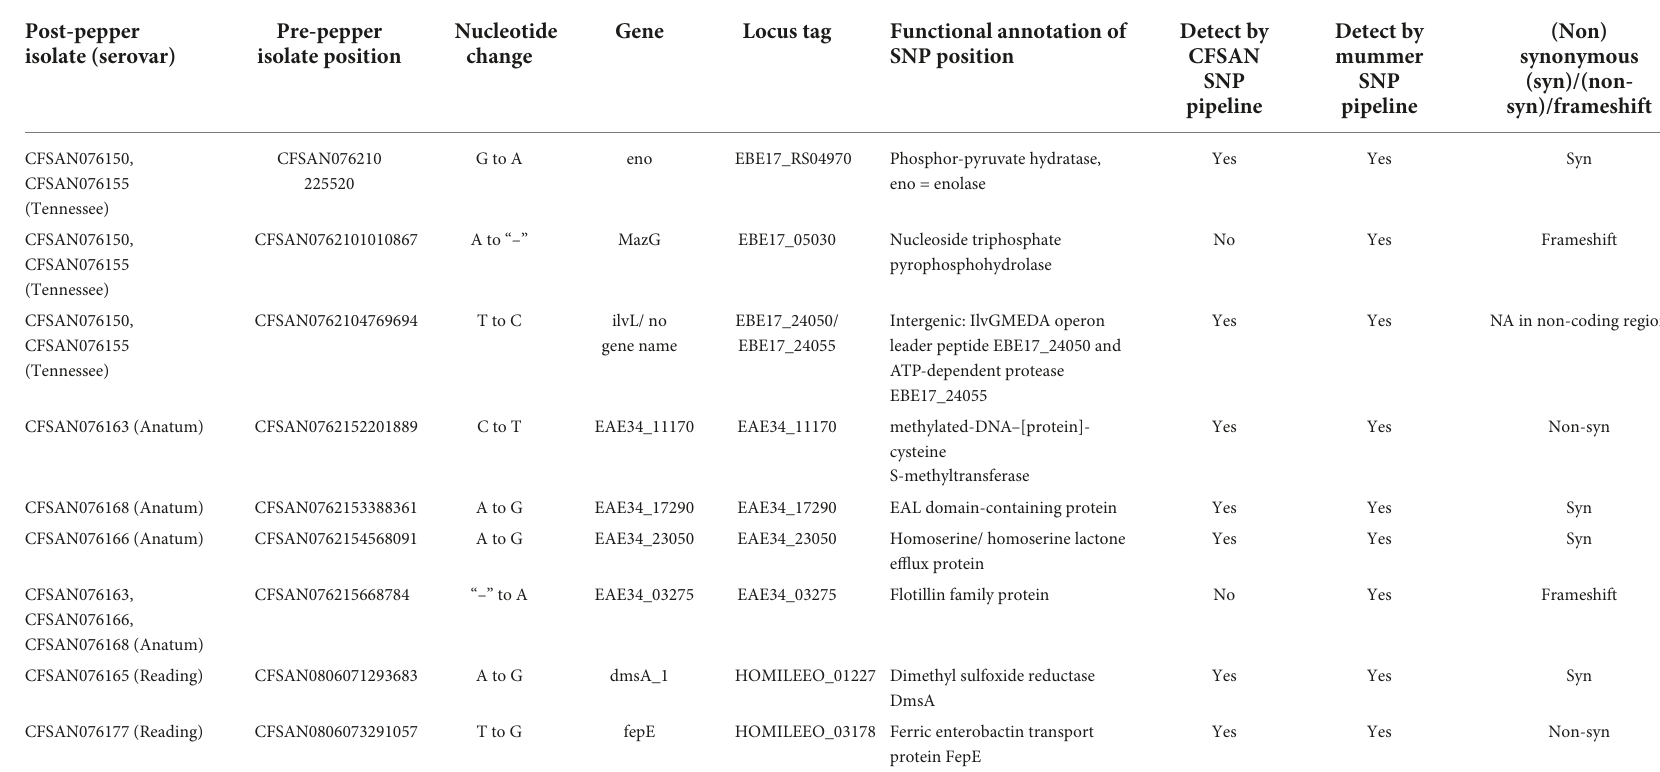
TABLE 2 Single nucleotide polymorphisms identified across all S. enterica